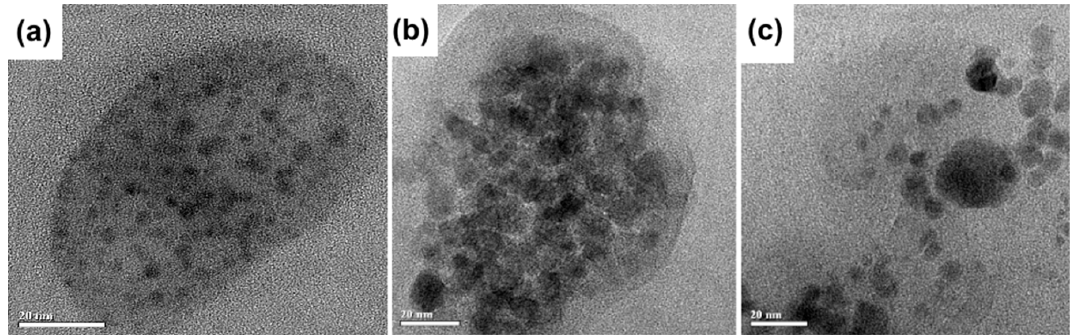
Figure 3. TEM images of Fe@C-NH 2 /Casein/Str ( a ), Fe@C-NH 2 /BSA/Str ( b ), and Fe@C-NH 2 /Gelatin B/Str ( c ). Scale bars are 20 nm.